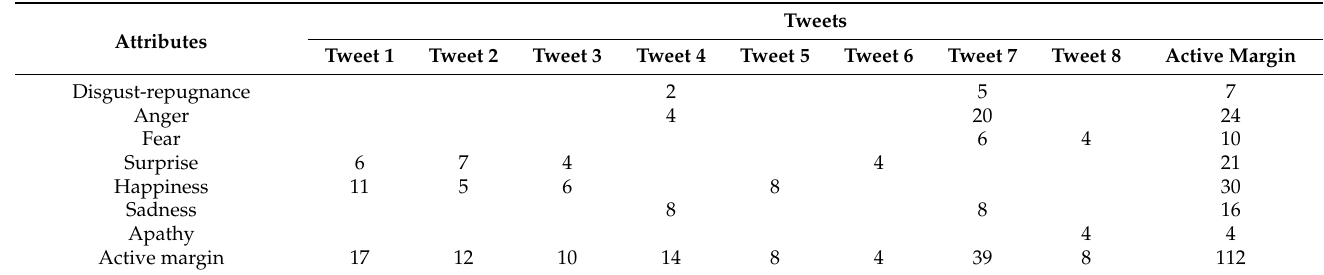
Table 6. Table of correspondences of absolute frequencies.